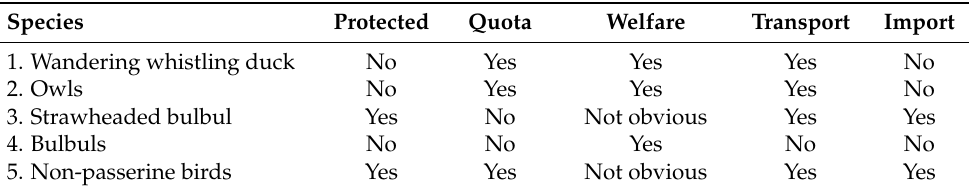
Table 5. Disentangling the legal and illegal aspects of the trade in birds in Indonesia. Listed are violations, presumed or evidenced, of protected species legislation, capture above permitted harvest quotas or capture in the absence of harvest quotas, violation of animal welfare legislation, violations of provincial transport restrictions, and the import of CITES listed birds in the absence of import permits. See text for